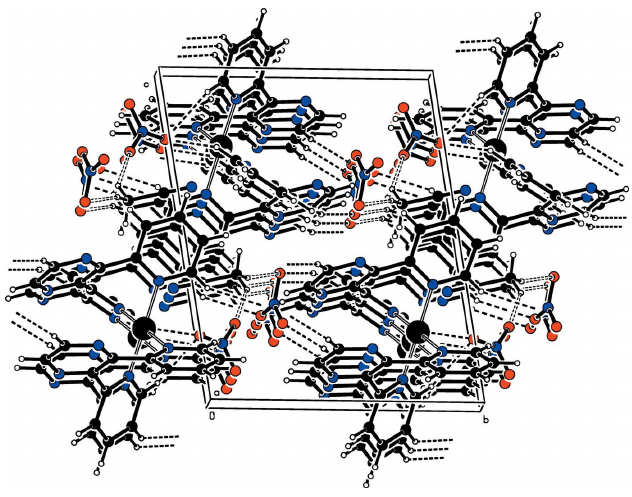
Figure 2 The packing in the crystal structure of the title compound, viewed approximately along the a axis. Hydrogen-bonding interactions are drawn as dashed lines.